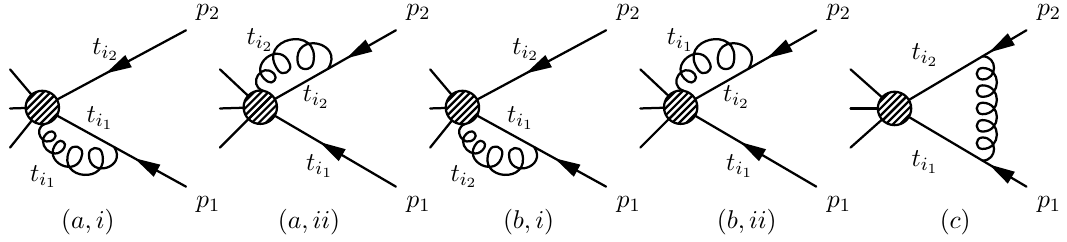
Figure 1 . Collinear loops contributing to the anomalous dimension for two fermionic building blocks in the i -th direction. Arrows show the fermion flow for two outgoing